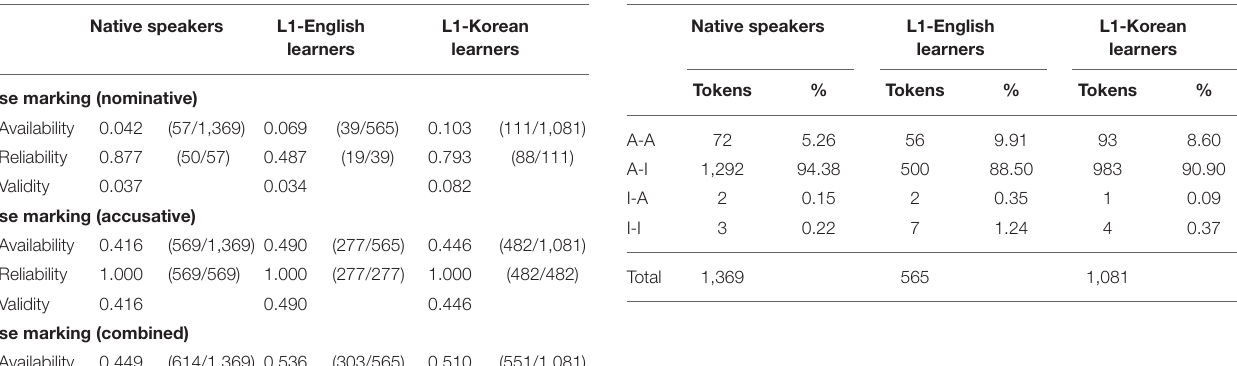
TABLE 10 | Animacy patterns by language